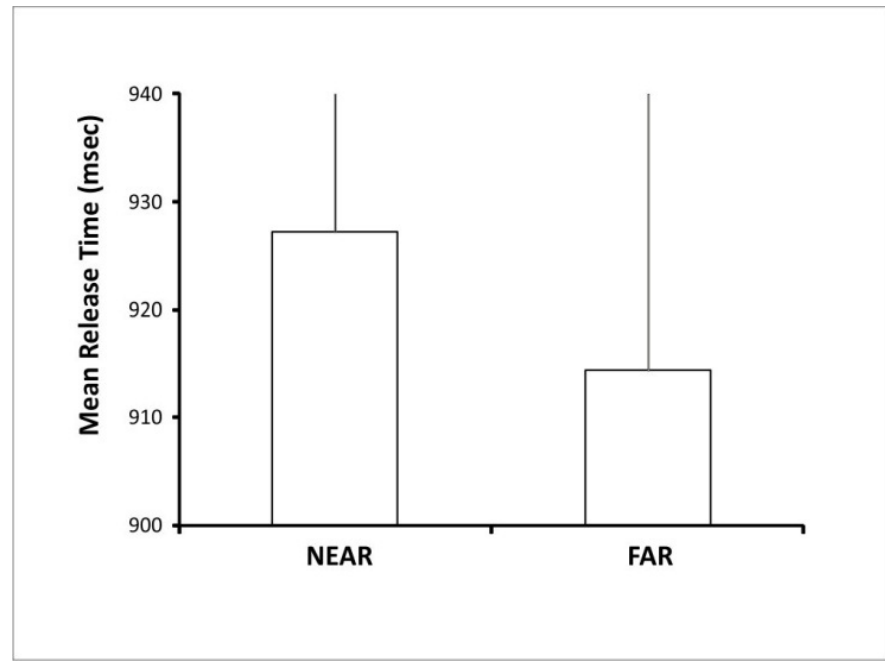
Figure 2. Behavioral results. The graph displays the mean release times for execution of the footstep action to far/panoramic vs. near/front views of the environmental layout. Error bars represent the standard error of the mean.